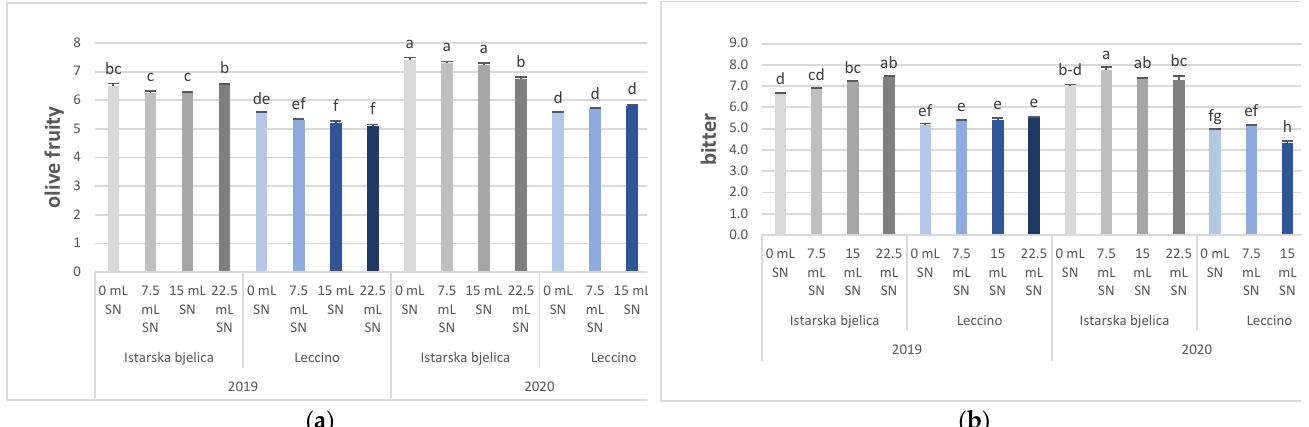
Figure 6. Multiple comparisons of the effects of treatment (T) (0, 7.5, 15, and 22.5 mL of applied SN foliar fertilizer per 1 L of water), cultivar (Cv.) (Istarska bjelica, Leccino), and year (Y) (2019, 2020) on the intensity of ( a ) olive fruity and ( b ) bitter attributes of olive oil. Different superscript lowercase letters represent statistically significant differences between the mean values at p < 0.05 that were obtained by a three-way ANOVA and Tukey’s test.